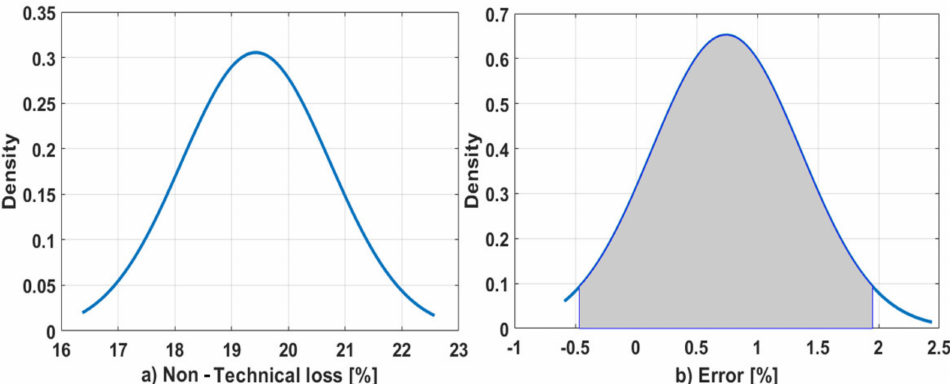
Figure 11. ( a ) Gaussian distribution of percentages of non-technical loss added to the base system; ( b ) Gaussian distribution of errors obtained between the real technical loss and the loss calculated by the EOI methodology.